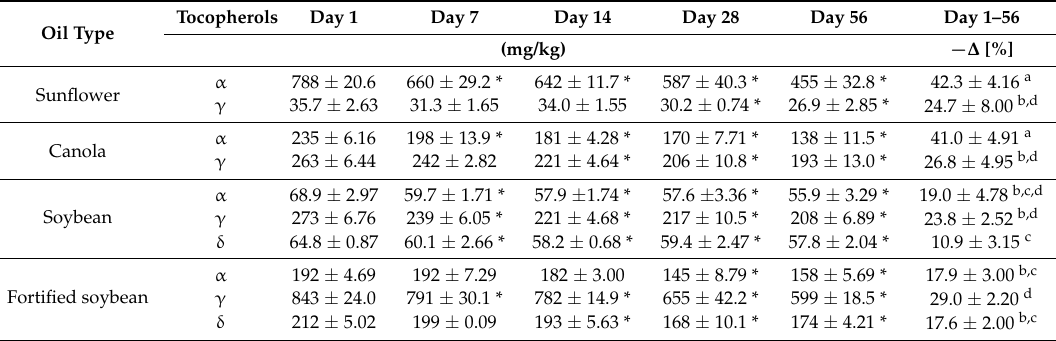
Table 3. Changes of tocopherol homologs in different oil types stored in a 12 h light/dark cycle at 22 ± 2 ◦ C for 56 days e